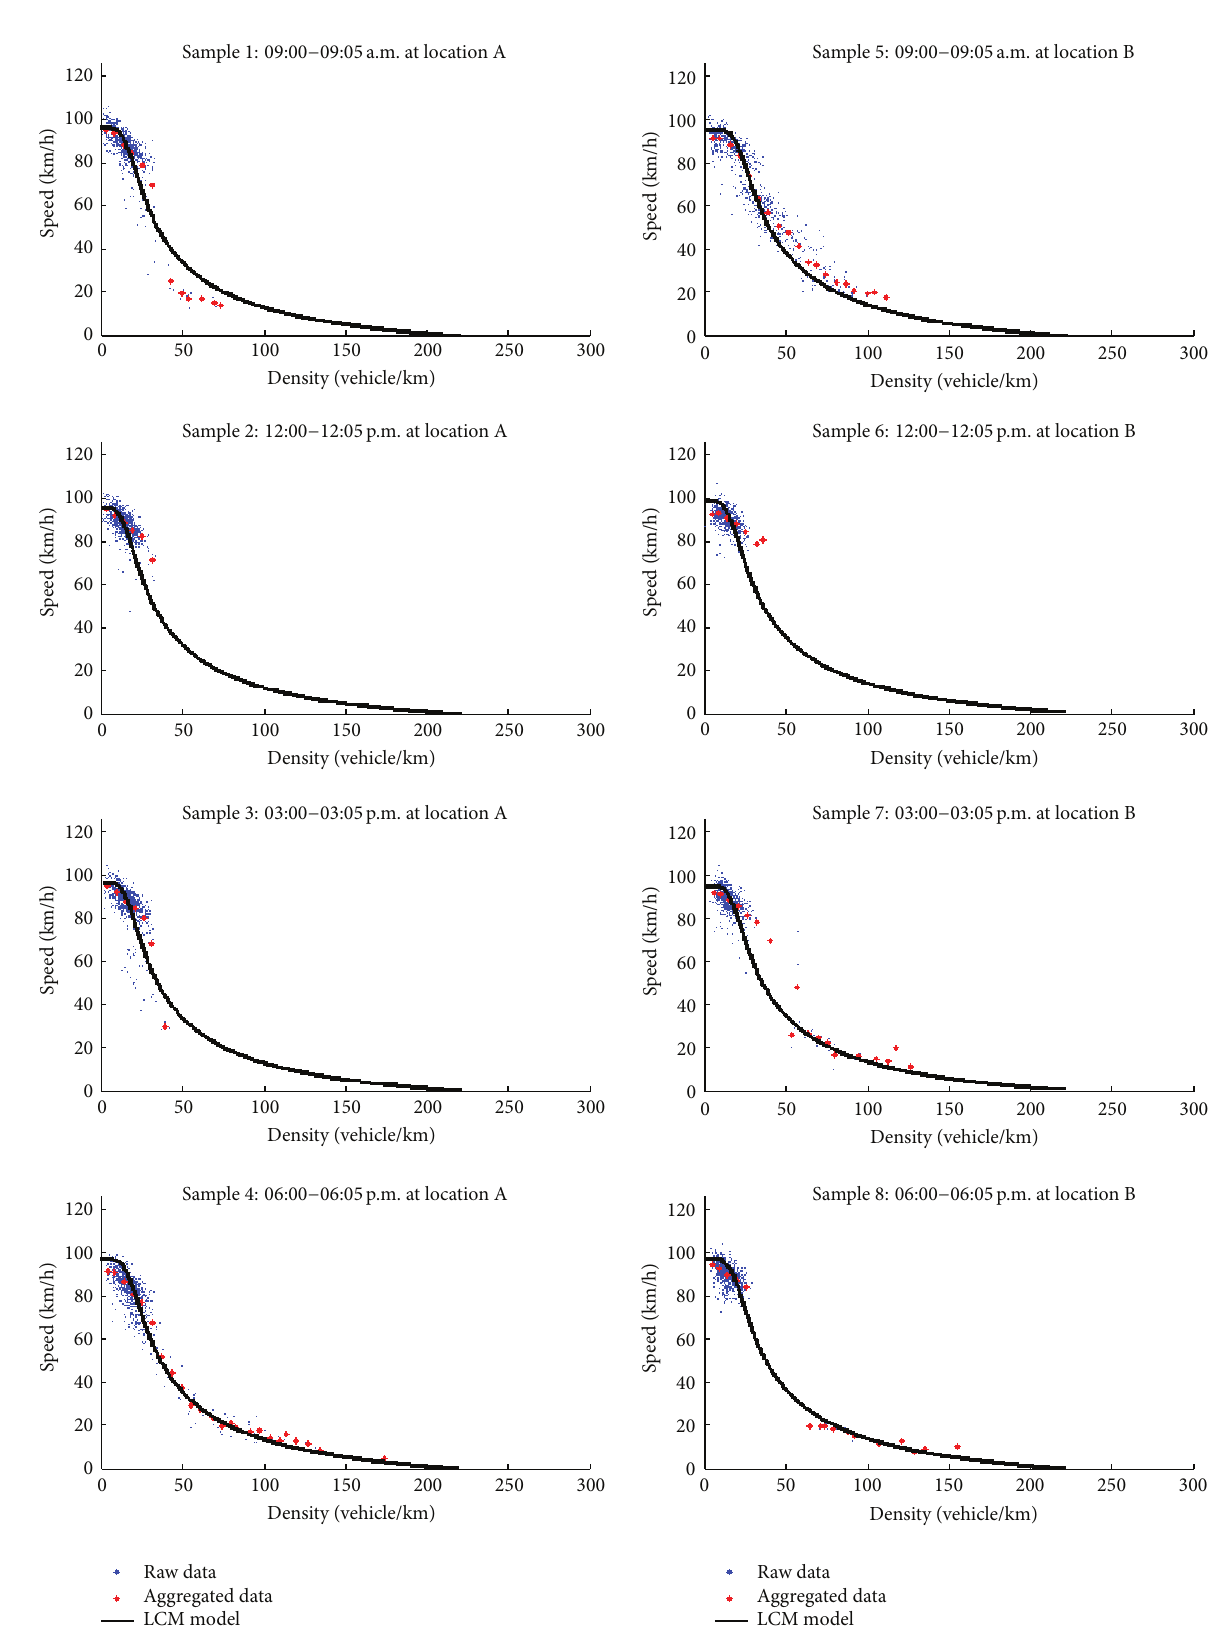
Figure 6: Calibration results for sample data sets by bisection based